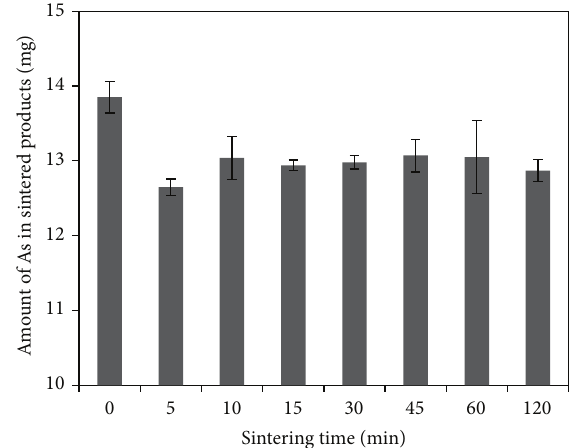
Figure 4: Effect of sintering time on the total amount of As in sintered products.